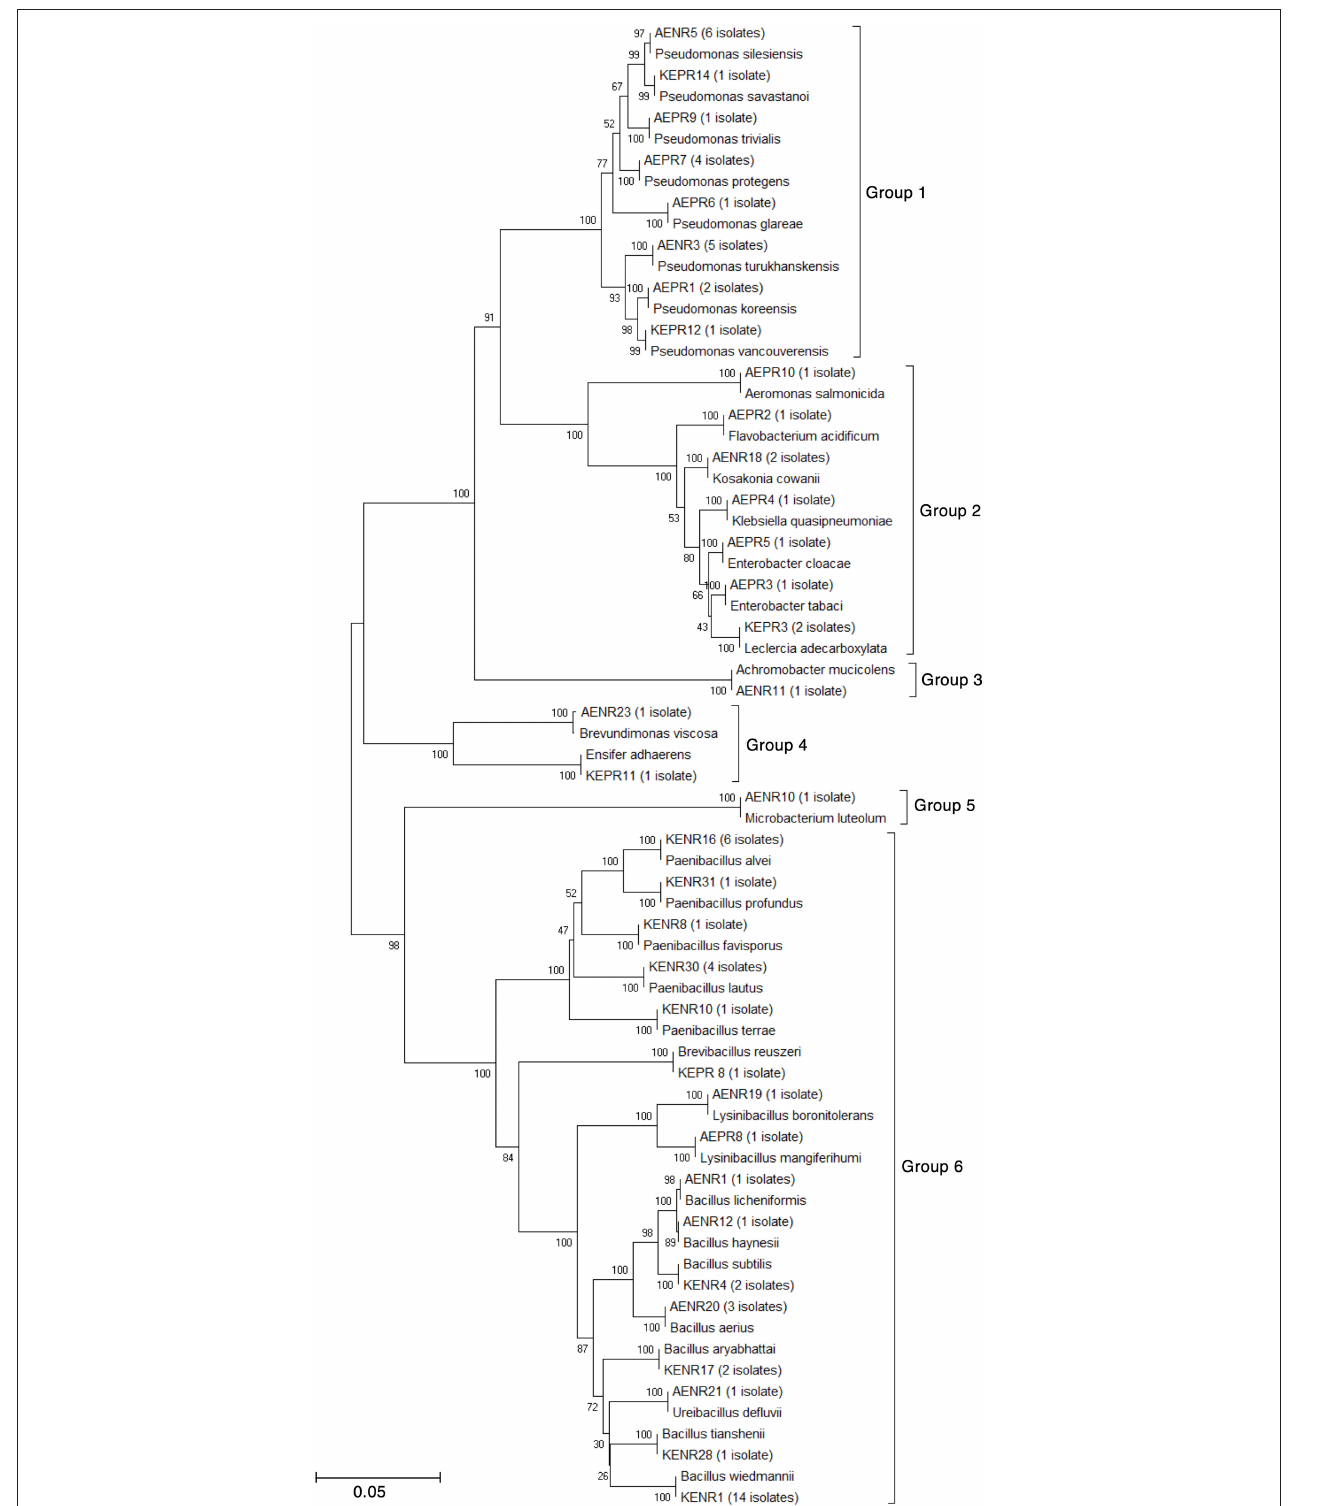
FIGURE 5 | Phylogenetic tree of bacterial isolates associated with rice roots grown under unfertilized nature farming.